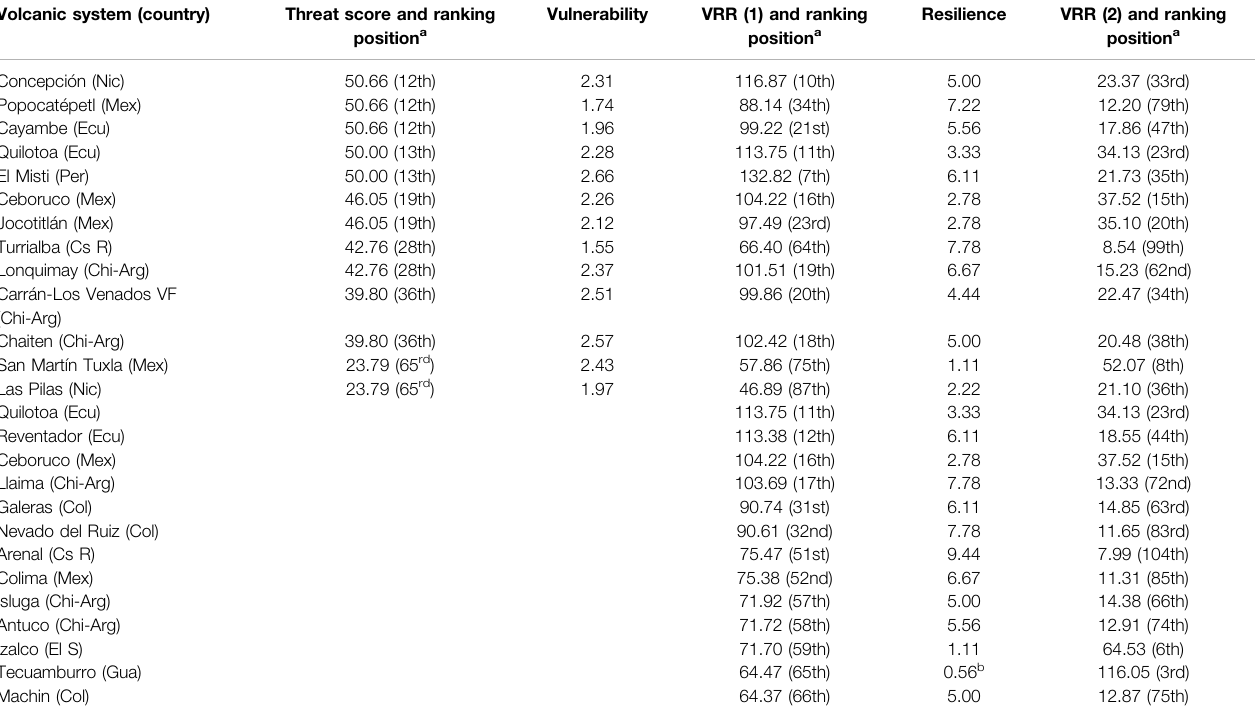
TABLE6| Comparativetableshowingtheeffectsofthevulnerabilityandresiliencefactors onsystemswiththesamethreatscoreandtheeffectoftheresilience(assessedin VRR (2)) on systems with similar VRR (1) score. The complete table of results, with the score of all factors, is available in the Supplementary Material 1 . Volcanic system (country) Threat score and ranking Vulnerability VRR (1) and ranking Resilience position a position a Concepción (Nic)